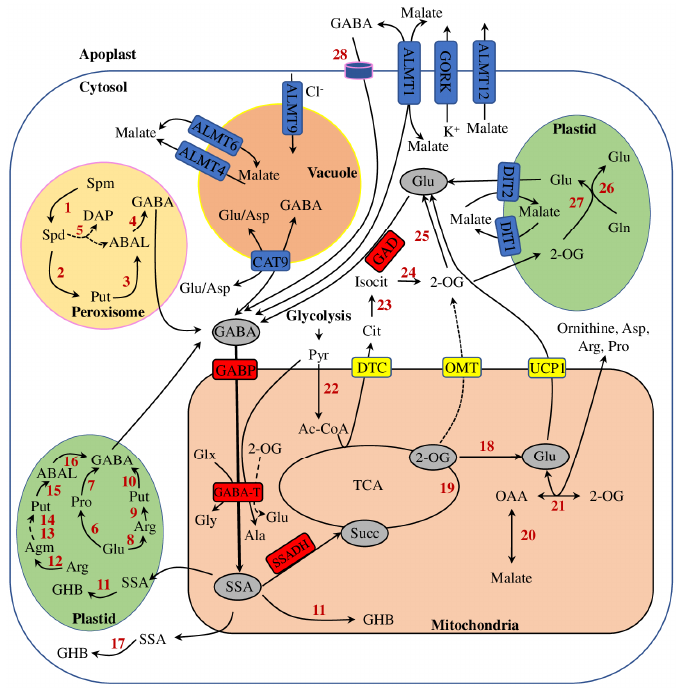
Figure 1. Representative model of Arabidopsis thaliana GABA metabolism and signaling. The grey ovals and red rectangles represent important metabolites and enzymes (GABA-T (GABA transami- nase), GABP (GABA permease), SSADH (succinic semialdehyde dehydrogenase), and GAD (gluta- mate decarboxylase), respectively, in the GABA shunt. Dashed lines represent metabolic pathways with insufficient experimental data. The yellow squares represent transporters linking the TCA cy- cle back to the GABA shunt, and the small blue squares represent transporters linking the GABA shunt to other metabolic pathways and organelles (DIT1, DIT2, and CAT9). The big blue squares represent GABA-regulated transporters (ALMTs and GORK). Abbreviations: GABA, γ −aminobu-